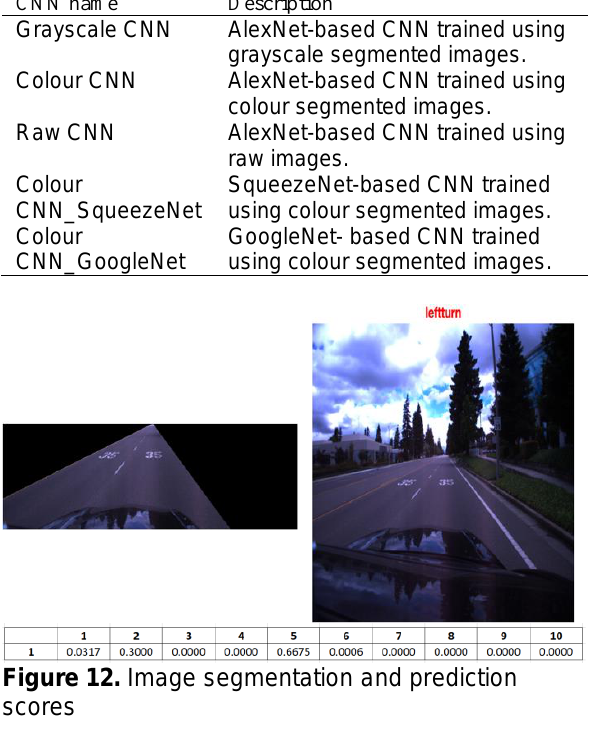
Figure 14. Training and test accuracy of ROI RESIZED + Colour CNN